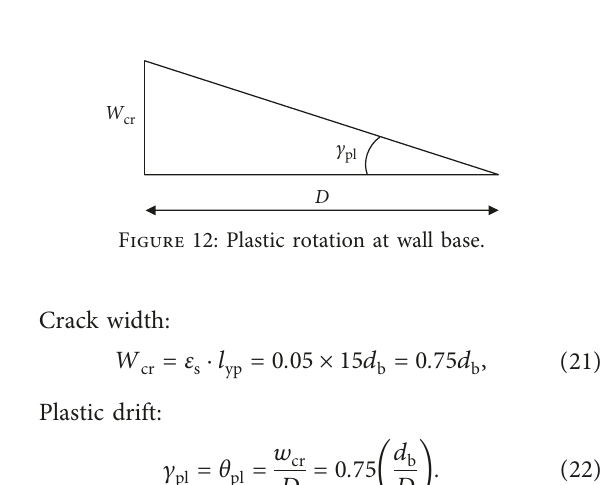
Figure 11: Plastic drift of simplified